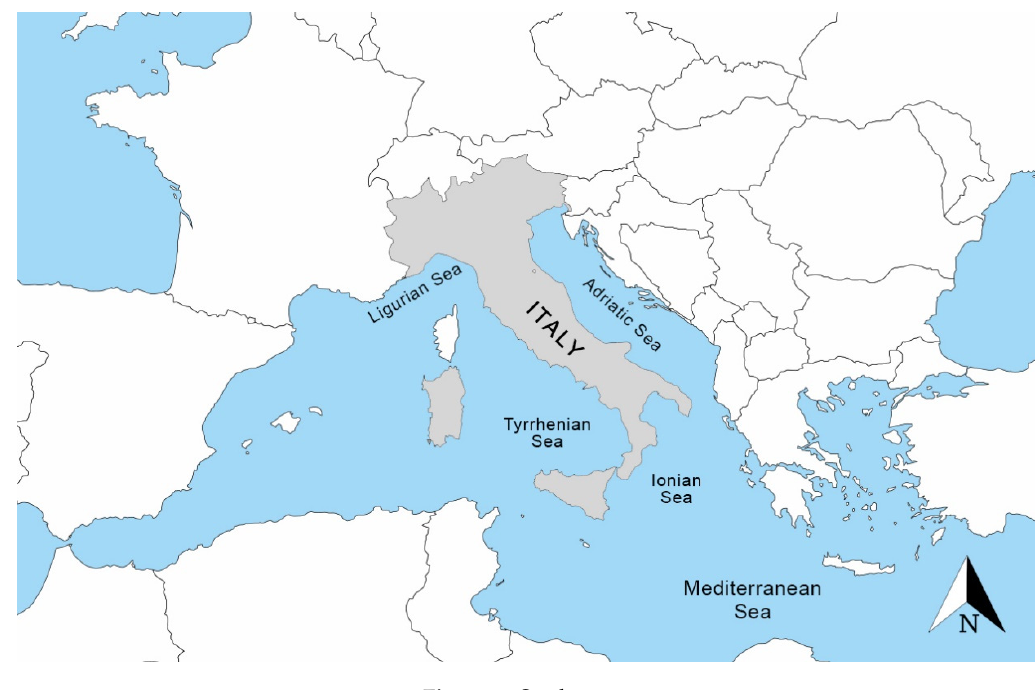
Figure 1. Study area. Table 1. List of threatened sharks in Italian seas considered in this study, based on the International Union for the Conservation of Nature (IUCN) Red List.